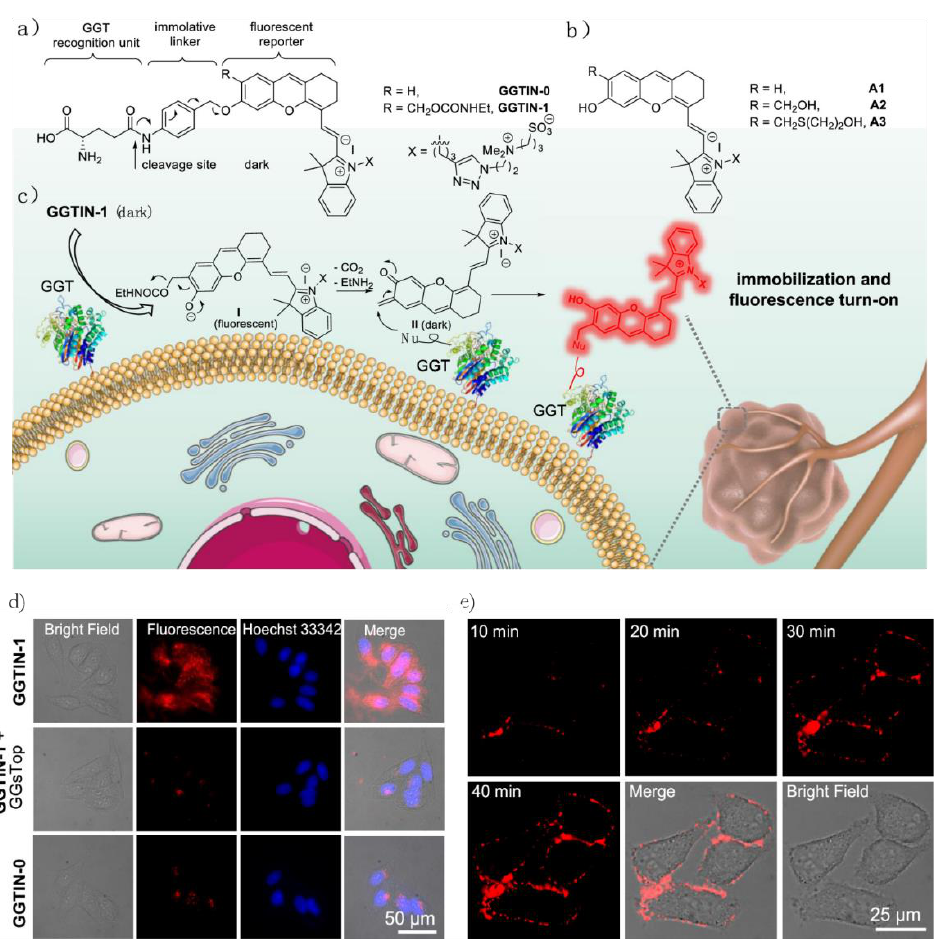
Figure 15. ( a ) Structures of GGTIN-0, GGTIN-1, ( b ) A1, A2, and A3. ( c ) Turn-on mechanism activated by γ -glutamyl transpeptidase. ( d ) Fluorescent imaging of γ -glutamyl transpeptidase activity in HepG2 cells or GGsTop (0.5 mM), a γ -glutamyl transpeptidase inhibitor pretreated HepG2 cells with GGTIN-0 and GGTIN-1 (5 µM, 37 °C, 1 h incubation). (e) Real-time and wash-free images obtained with the use of GGTIN-1. Reprinted with permission from [69], copyright 2020 American Chemical Society.